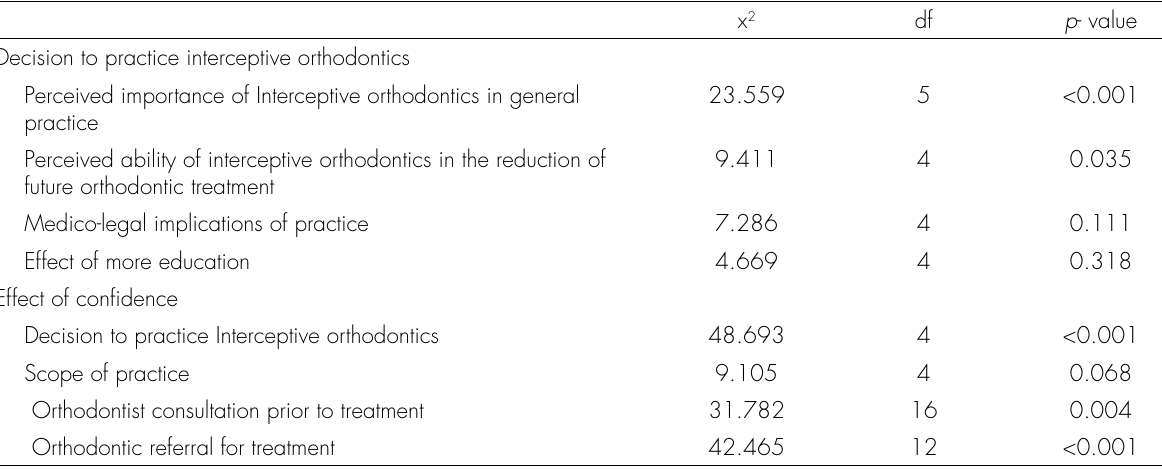
Table V. Statistical analysis of factors affecting interceptive orthodontic